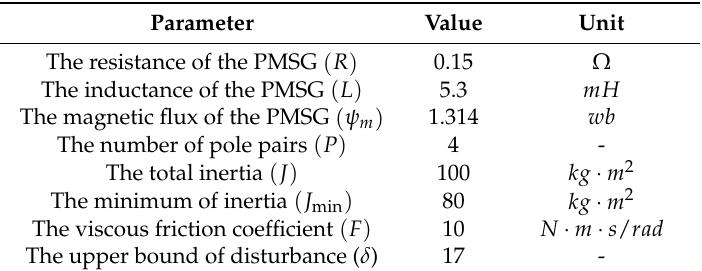
Table 1. The parameters of the wind turbine and the PMSG.